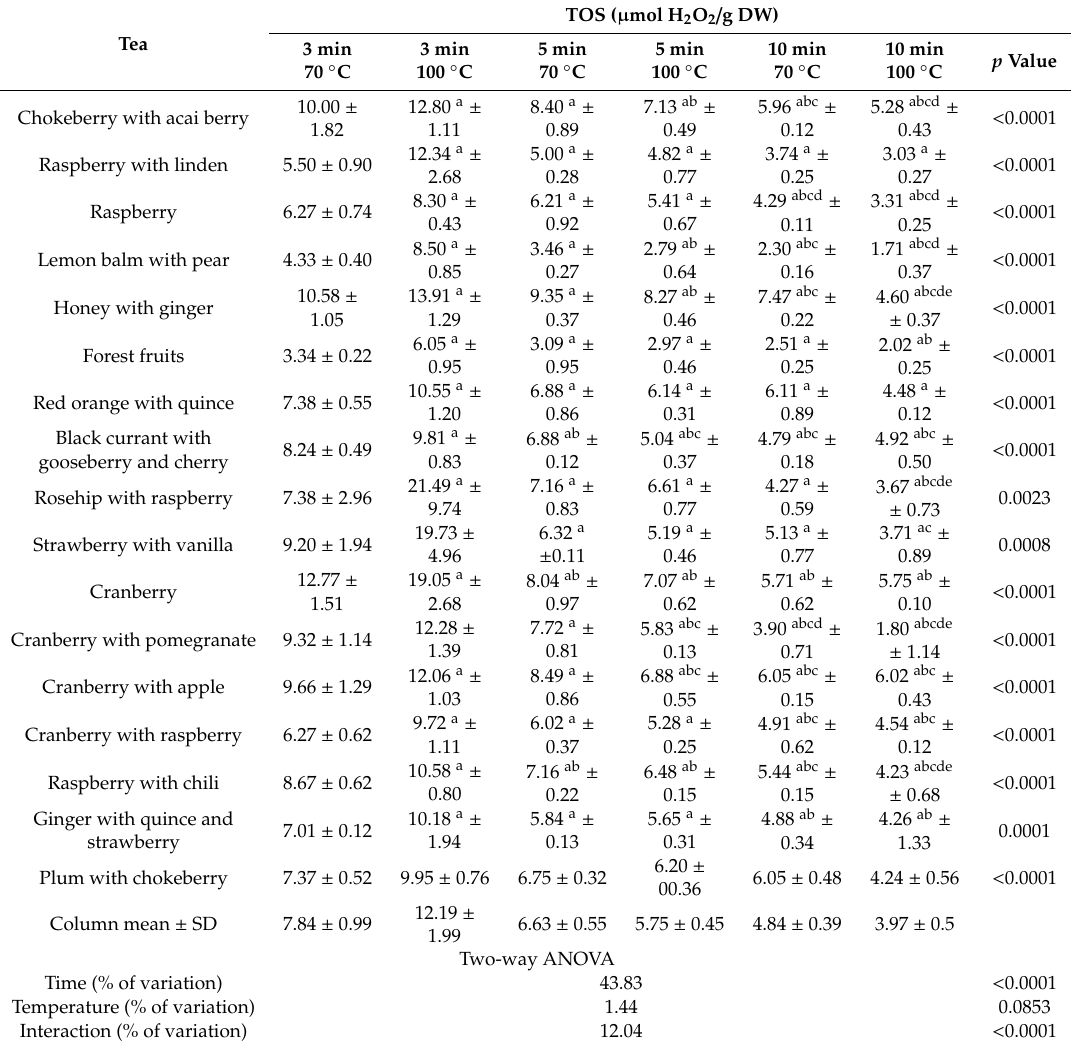
Table 6. Total oxidant status (TOS) in fruit tea infusions. a p < 0.05 vs. 3 min 70 ◦ C; b p < 0.05 vs. 3